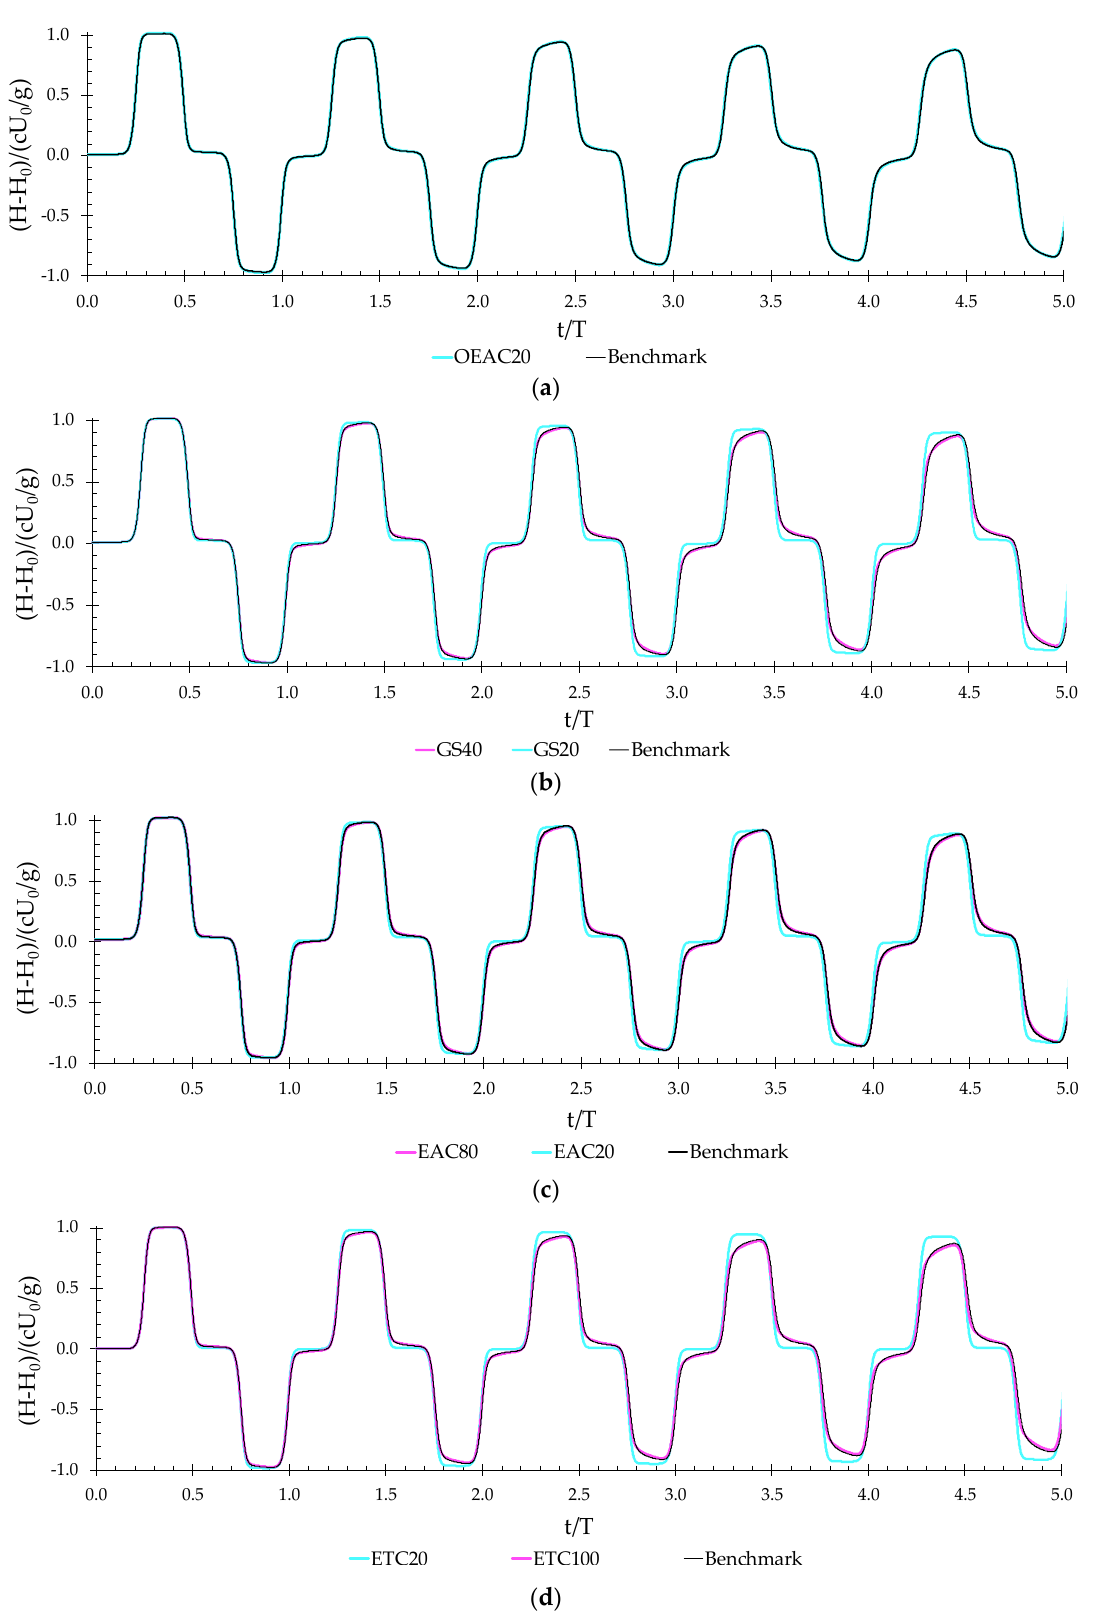
Figure 14. Piezometric head time history for the S-shape valve closure: ( a ) OEAC, ( b ) GS, ( c ) EAC, and ( d ) ETC.